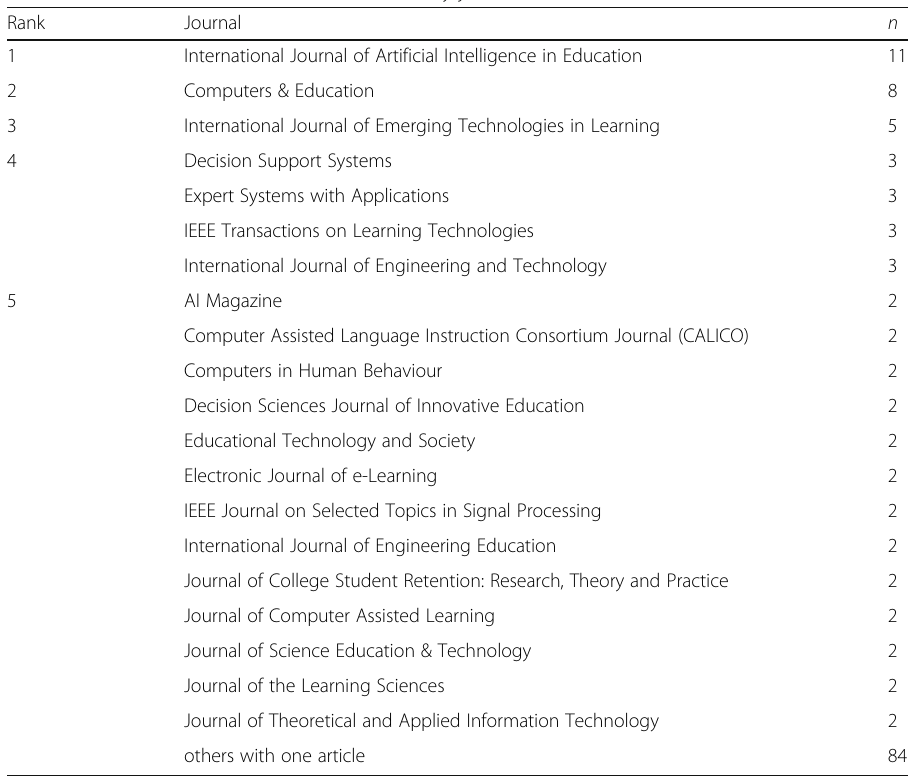
Table 3 Number of included articles ( n = 146) by journal